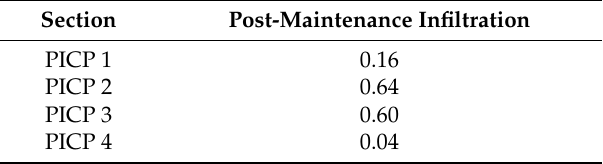
Table 9. Overall Inter group significance of difference of the two-sided generalized Wilcoxon